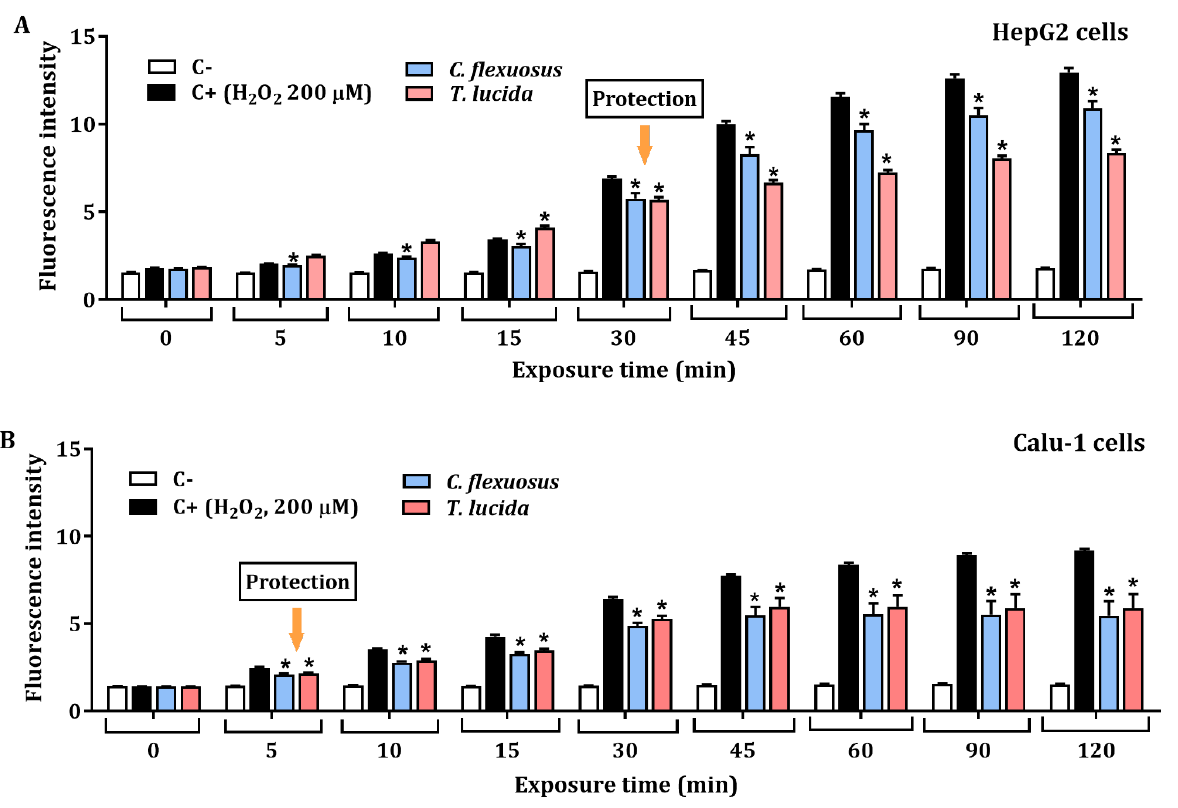
Figure 3. Protective effect at 15.6 µg/mL of C. flexuosus and T. lucida EOs against H 2 O 2 -induced ROS in HepG2 ( A ) and Calu-1 ( B ) cell lines. Cells were pretreated with each EO for 24 h. Culture medium and H 2 O 2 (200 μM) served as negative (C -), and positive control (C+), respectively. * Significant difference when compared to the positive control ( p < 0.05).